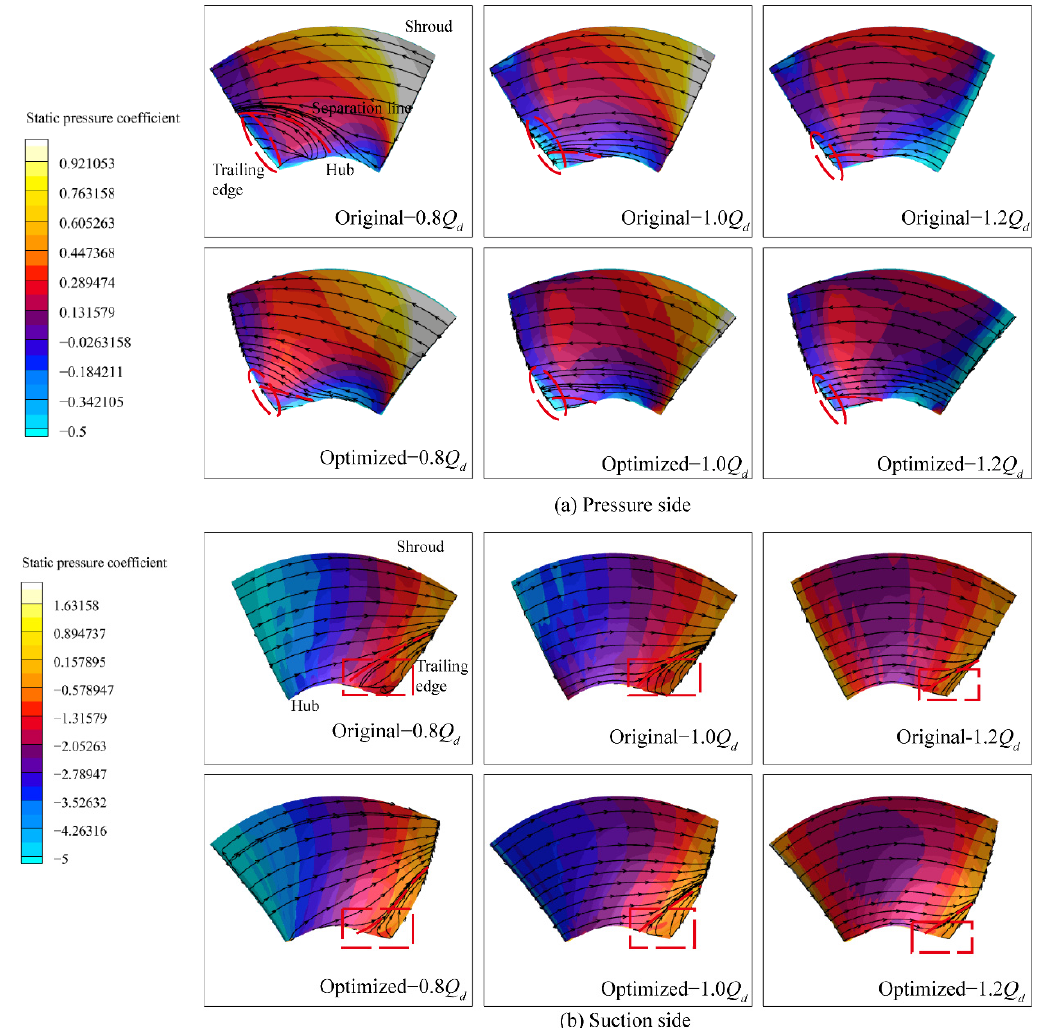
Figure 15. Surface pressure and streamline distribution of the blade.